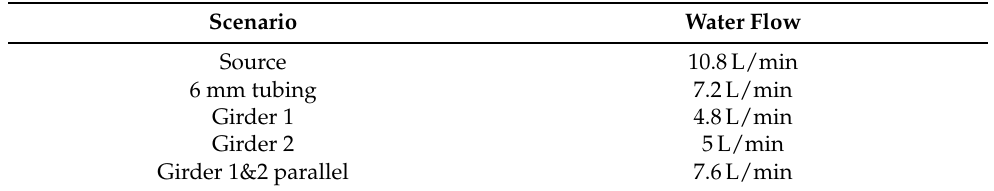
Table 2. Waterflow Measurement.